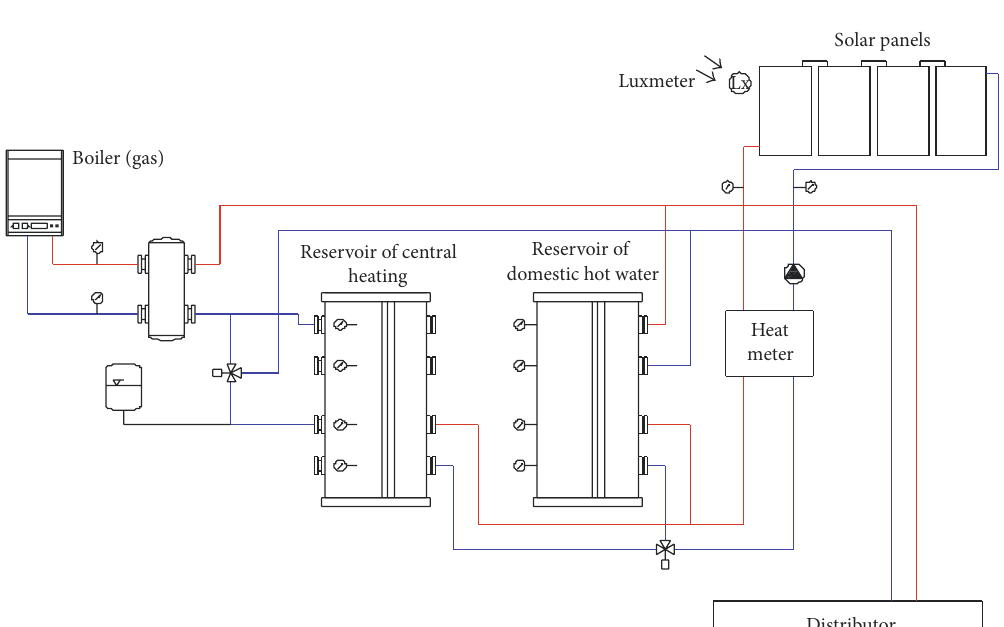
Figure 6: A diagram of a part of a multivalent laboratory system used in the